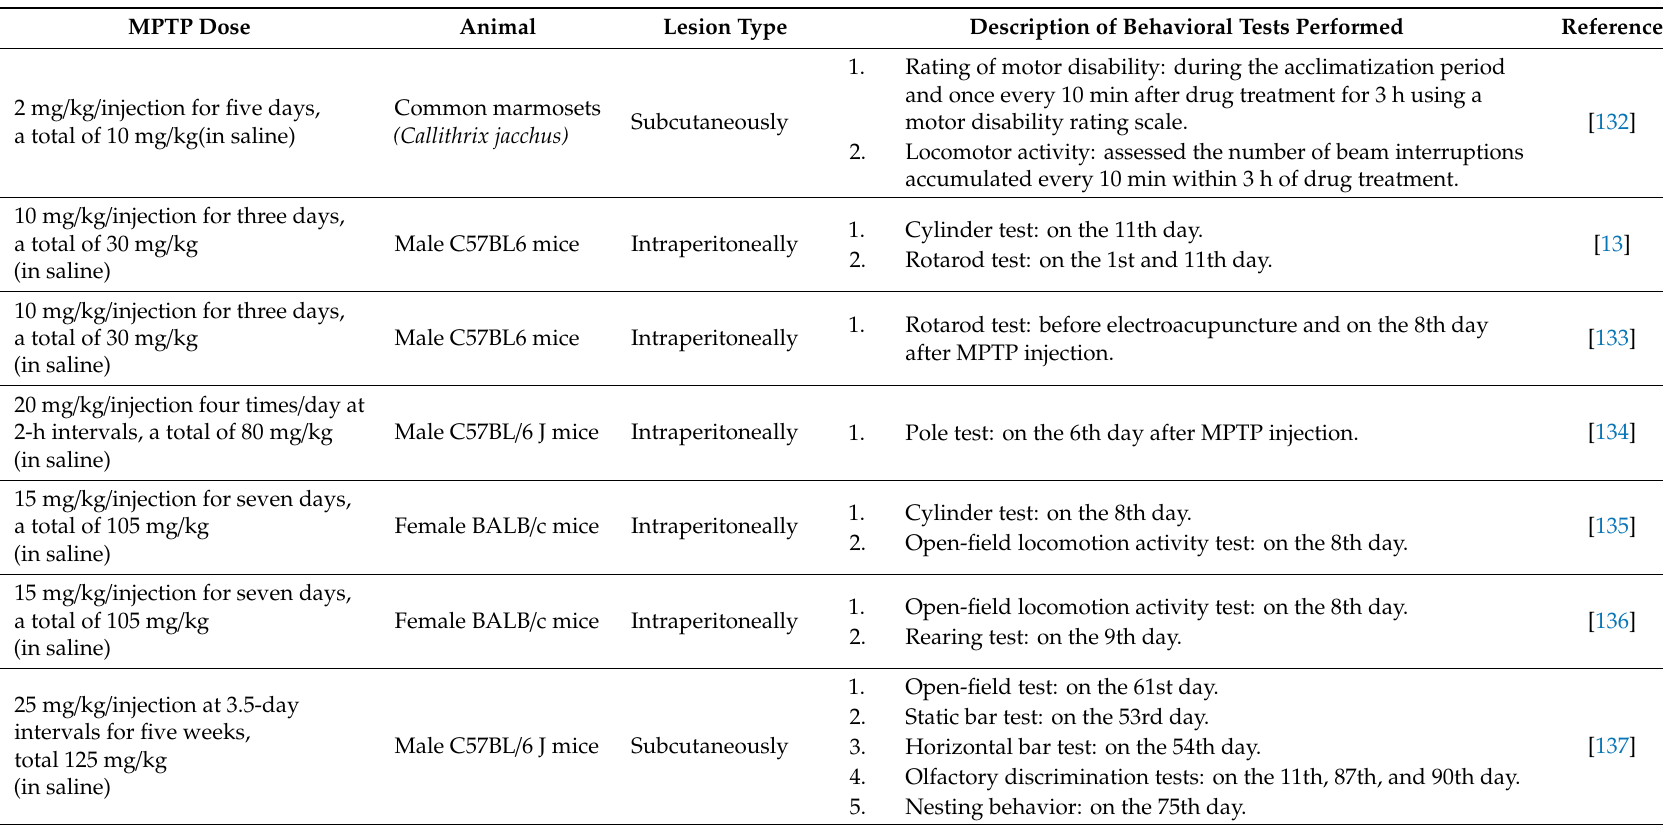
Table 3. The dose, lesion type and behavioral evaluating methods in each MPTP-induced PD animal